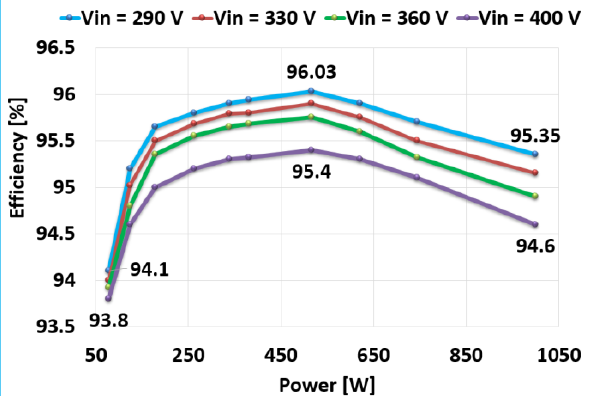
Figure 19. Efficiency plots during function III operation with wide range of input voltage variation.